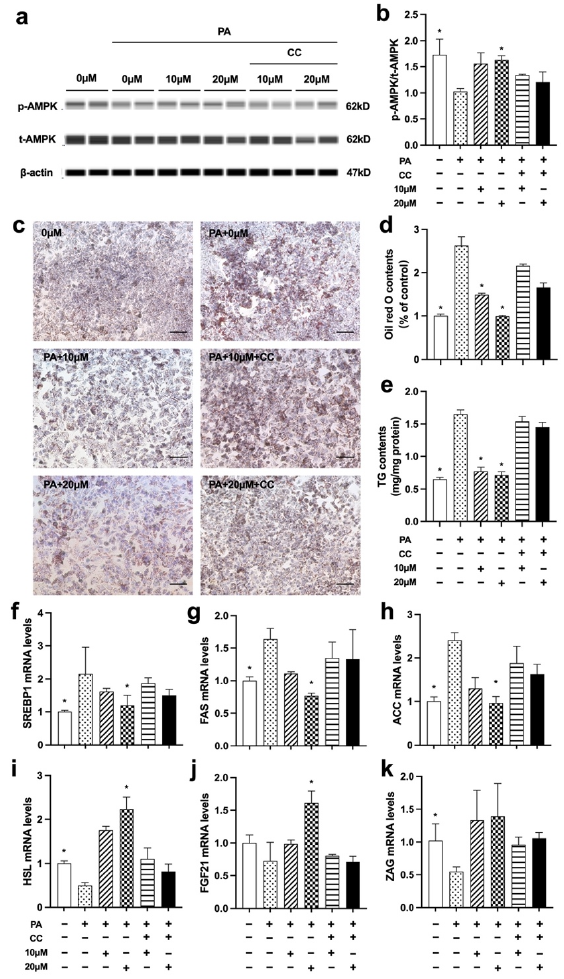
Figure 6. Nuci prevented PA-induced cellular steatosis by activating AMPK phosphorylation in HepG2 hepatocytes. HepG2 hepatocytes were cultured and treated according to the scheme described in Method 2.9. The protein levels of p-AMPK, t-AMPK, and β -actin were analyzed by Simple western ( a ), the expression of p-AMPK was normalized against t-AMPK ( b ). Oil red O staining was conducted and photographed at 100 × magnification ( c ) and Oil red O dye was extracted and detected ( d ). Intracellular TG contents I were determined by a commercial kit following the manufacturer’s instructions. The mRNA expressions of SREBP1 ( f ), FAS ( g ), ACC ( h ), HSL ( i ), ZAG ( j ), and FGF21 ( k ) were determined by RT-qPCR. Data were presented with mean ± SE from three independent experiments, * p < 0.05 vs. the PA group (PA + 0 μ M).